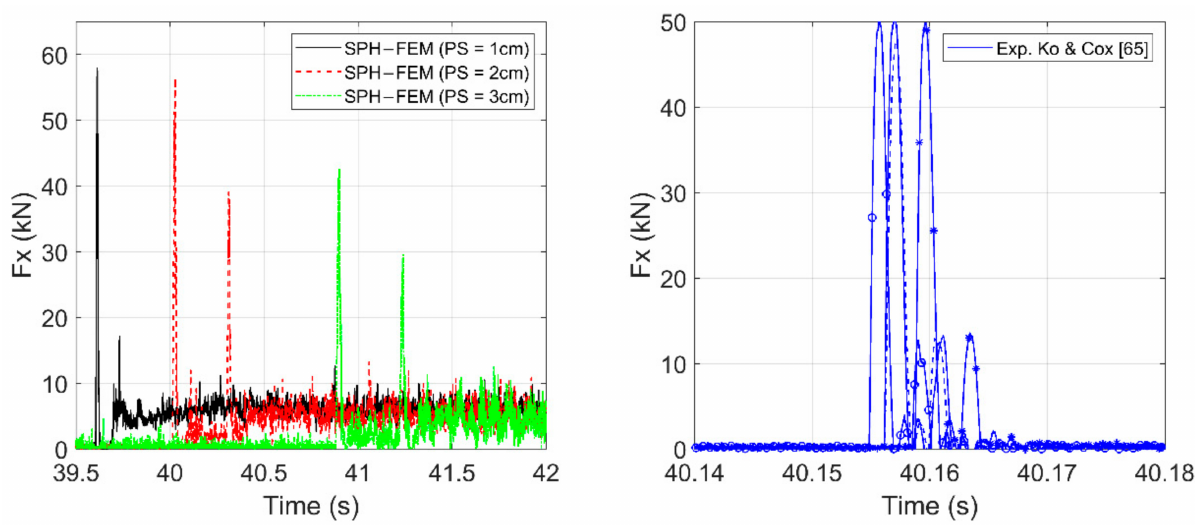
Figure A3. Debris impact forces. Experimental [65] and numerical results for three particle sizes, for h 1 = 2.496 m and T erf = 30